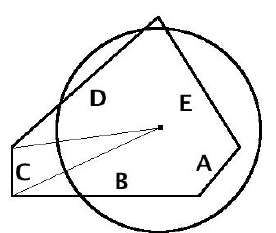
Figure 5. Mapping an edge (C) to the bounding circle: We draw straight lines from the vertices of the edge to the center of the circle and use the intersection points of these lines and the circle as the two end points of the new line. Figure 4 gives an example of a Voronoi cell (the pentagon) of which we want to restrict the distance between its vertices (corner points) and the data point. The circle shows the target maximum size of the cell. In our visualisation tool the diameter of this circle is a value which is determined by the user. The five cell edges are examples of the possible edge variants with respect to the circle limit: